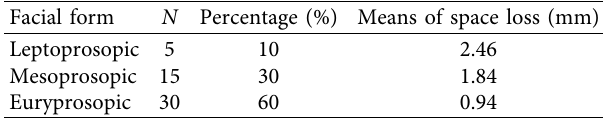
Table 3: Relationship between facial form and space loss. Facial form